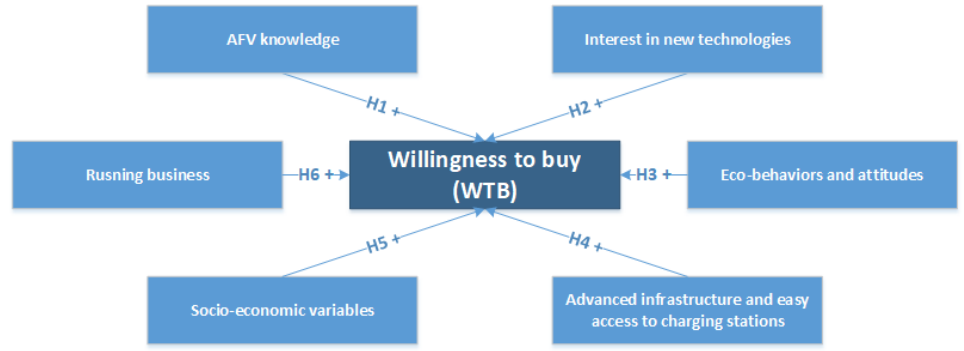
Figure 1. Research framework of the consumer willingness to buy (WTB) of